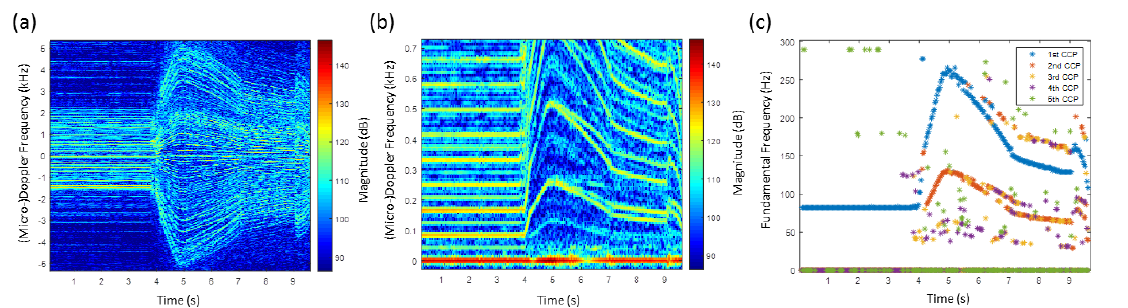
Figure 11. ( a ) HERM lines spectrogram for hexacopter measured by W-band radar; ( b ) zoomed into the HERM lines spectrogram showing individual HERM lines; ( c ) corresponding multi-frequency detector